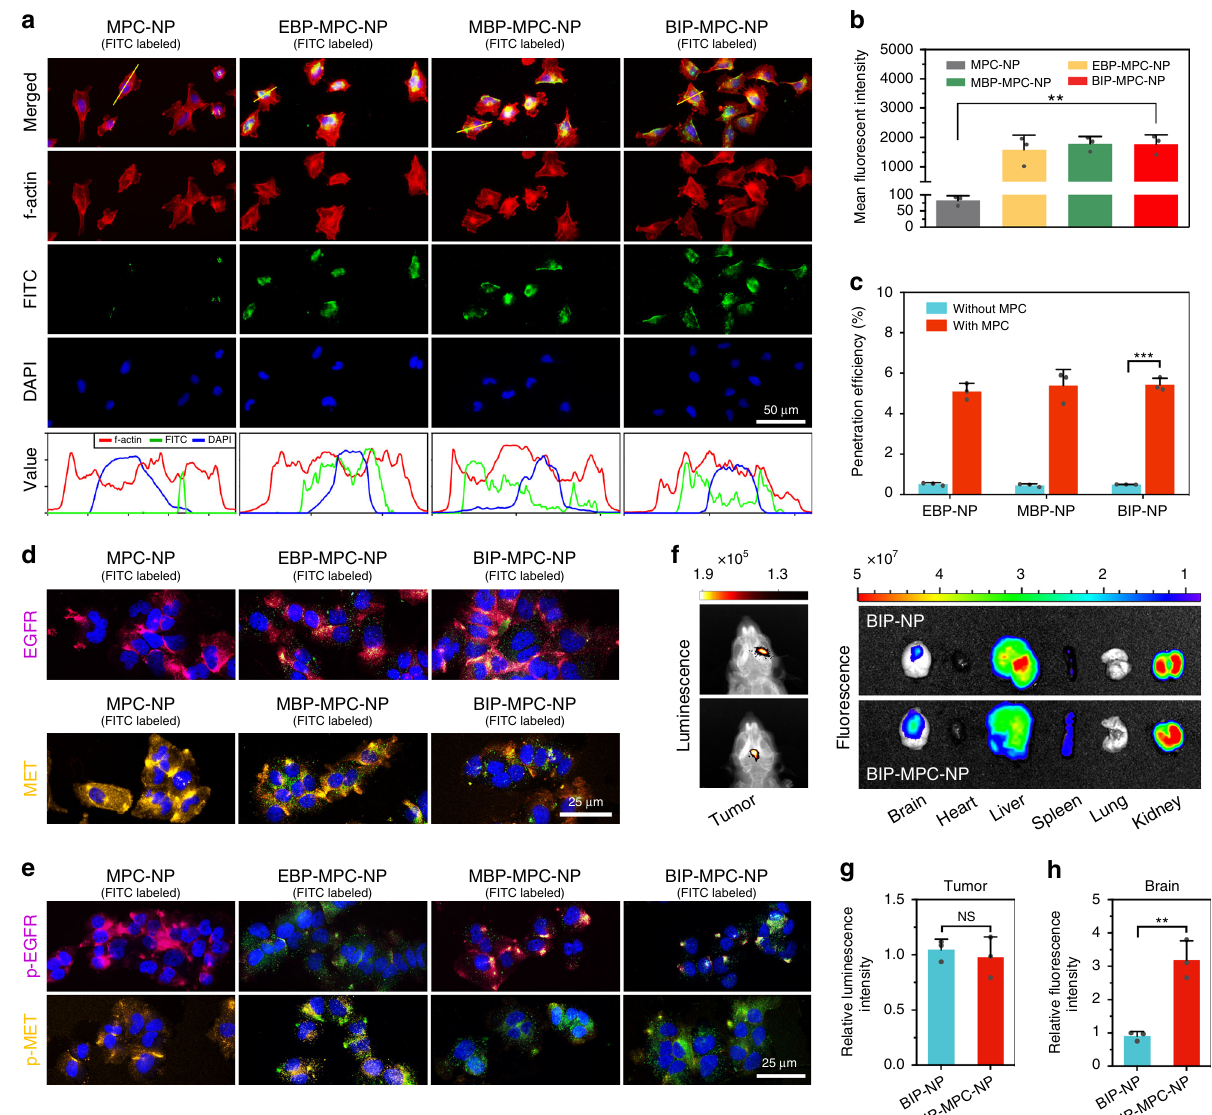
Fig. 2 The biological activity of nanoinhibitors. a The fl uorescence assays showed the localization of EBP-MPC-NP, MBP-MPC-NP or BIP-MPC-NP on the LN229R cell surface. The gray value was displayed in line plots. Scale bar = 50 μ m. b The fl ow cytometric analysis of cells with MPC-NP, EBP-MPC-NP, MBP-MPC-NP or BIP-MPC-NP in vitro ( n = 3). c The transportation assays showed the permeability of EBP-MPC-NP, MBP-MPC-NP and BIP-MPC-NP in vitro ( n = 3). d The binding af fi nity of MPC-NP, EBP-MPC-NP, MBP-MPC-NP or BIP-MPC-NP after penetrating BBB models. Scale bar = 25 μ m. e The IF assays showed the attenuation of p-EGFR and p-MET by administration of MPC-NP, EBP-MPC-NP, MBP-MPC-NP or BIP-MPC-NP in BBB model. Scale bar = 25 μ m. f Ex vivo fl uorescence and bioluminescence images of the visceral organs after the injection of BIP-NP or BIP-MPC-NP in mice. g , h The histogram summarized the relative luminescence intensity and the relative fl uorescence intensity of tumor-bearing brains. The error bars in b , c , g and h represent the S.D. of three measurements ( n = 3). P value is determined by Student ’ s t -test. Signi fi cant results are presented as NS non-signi fi cant, ** P < 0.01, or *** P < bEnd.3 layer (Fig. 2c, Supplementary Fig. 6b). After penetrating ex vivo imaging 5 h post the injection. According to the results BBB model, the nanoinhibitors also had strong fl uorescent (Fig. 2f – h, Supplementary Fig. 6d, e), the fl uorescence signal of intensities (Supplementary Fig. 6c) and the binding af fi nity tar- Cy5.5-labeled BIP-MPC-NP was observed clearly in the mouse geting EGFR and MET (Fig. 2d). The expressions of p-EGFR and brains and showed a 3.2-fold higher increase than BIP-NP, p-MET were simultaneously attenuated by BIP-MPC-NP pene- indicating effective BBB permeability. The ex vivo fl uorescence trating BBB model (Fig. 2e). images of the sliced tumor-bearing brain tissues showed the enhanced distribution of Cy5.5-labeled BIP-NP with MPC (Supplementary Fig. 6f). These results demonstrated that the nanoinhibitors were internalized into glioma tissues in vivo and BIP-MPC-NP had a more effective BBB permeability than BIP-NP.